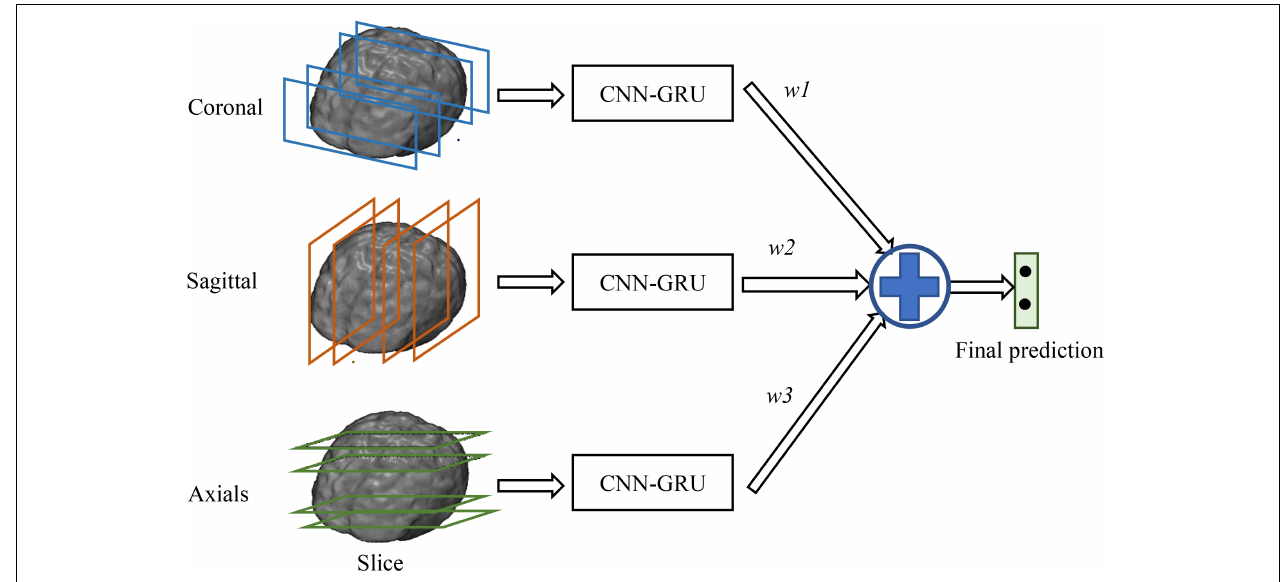
FIGURE 3 | Final ensemble of multi-view